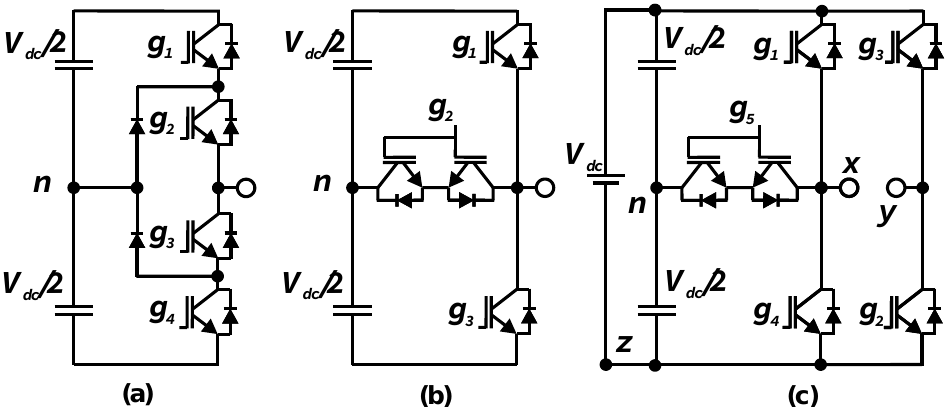
Figure 1. Phase-leg three-level multilevel inverter power Circuits: ( a ) Traditional 3-level diode-clamed MLI, ( b ) T-type 3-level NPC inverter, ( c ) 5-level single-phase switch-clamp inverter.